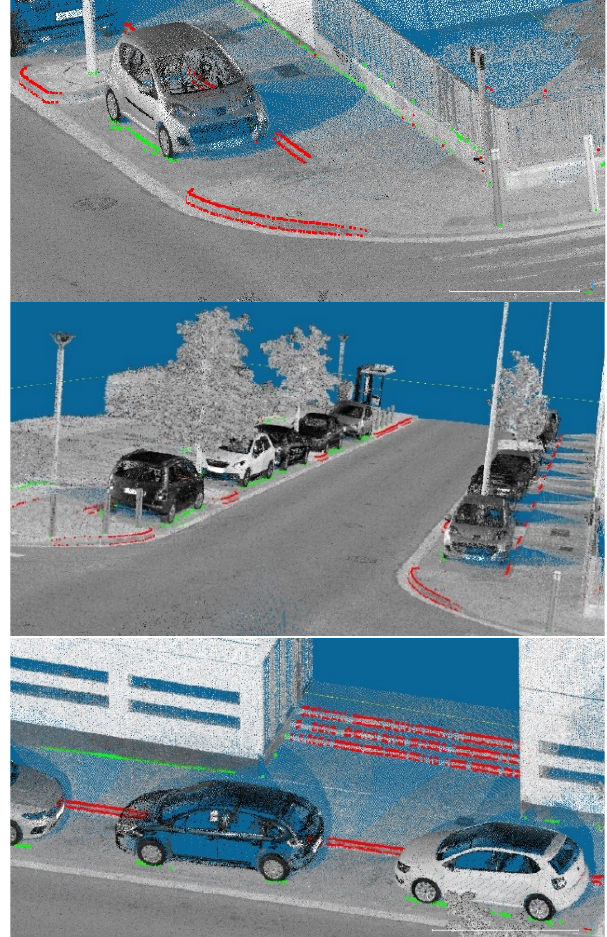
Figure 8 : Point cloud obtained by MMS in an urban area. Top and bottom point of curb in red; Vertical object projections on the ground in